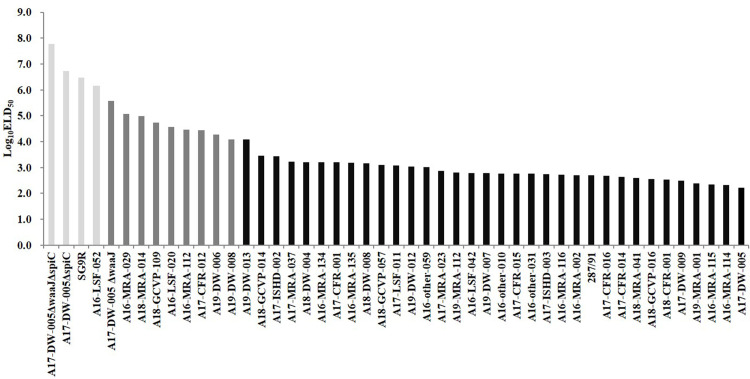
Log10ELD50 of 13-day-old chicken embryos
inoculated by the AC with S. Gallinarum field strains
in the chicken ELA.The avirulent strains (Log10ELD50 ≥ 6.1) were
displayed in the light grey columns; the moderately virulent strains
(4.0 < Log10ELD50 > 6.1) were displayed in
the deep grey columns; the virulent strains
(Log10ELD50 ≤ 4.0) were displayed in the black
columns.